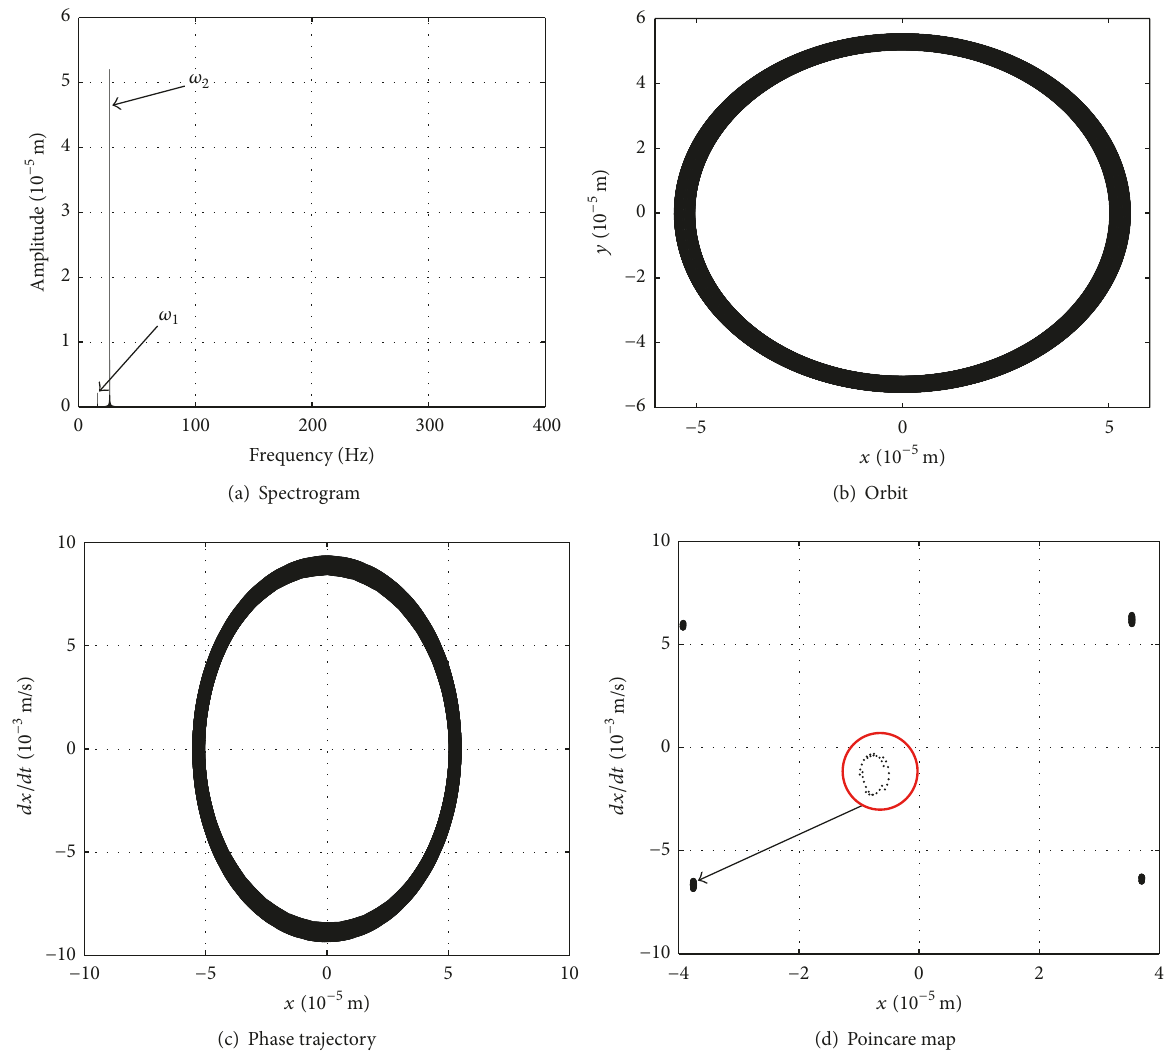
Figure 10: Response analysis of disk 2: 𝜔 1 = 102 rad / s and 𝜆 = −1.65 .